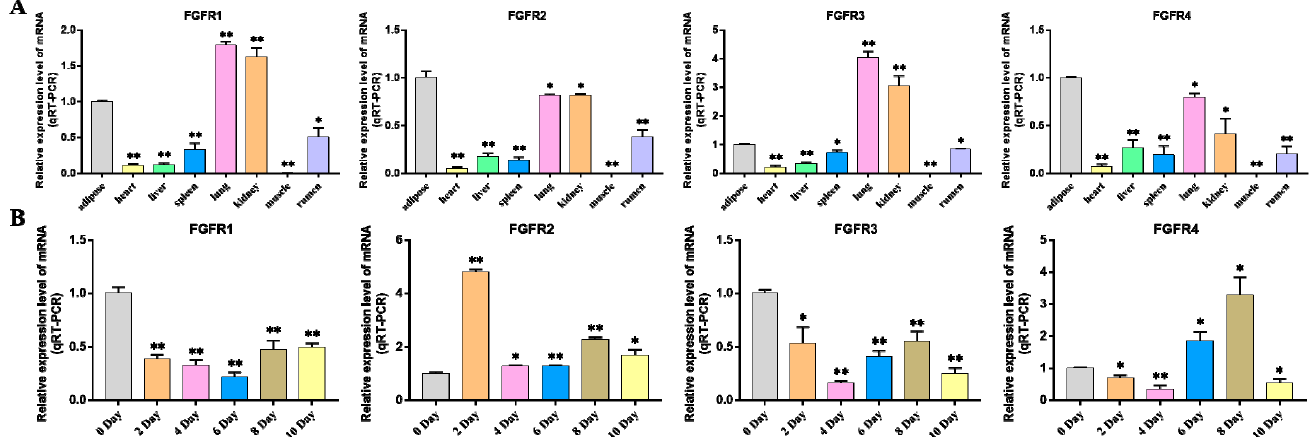
Figure 9. Expression assay of FGFRs genes. ( A ) Detection of FGFRs gene expression profile in different tissues of cattle. ( B ) Detection of FGFRs gene expression profile during bovine adipocyte differentiation. Compared with the control, “*” means a significant difference ( p < 0.05), “**” means an extremely signi fi cant di ff erence ( p < 0.01).